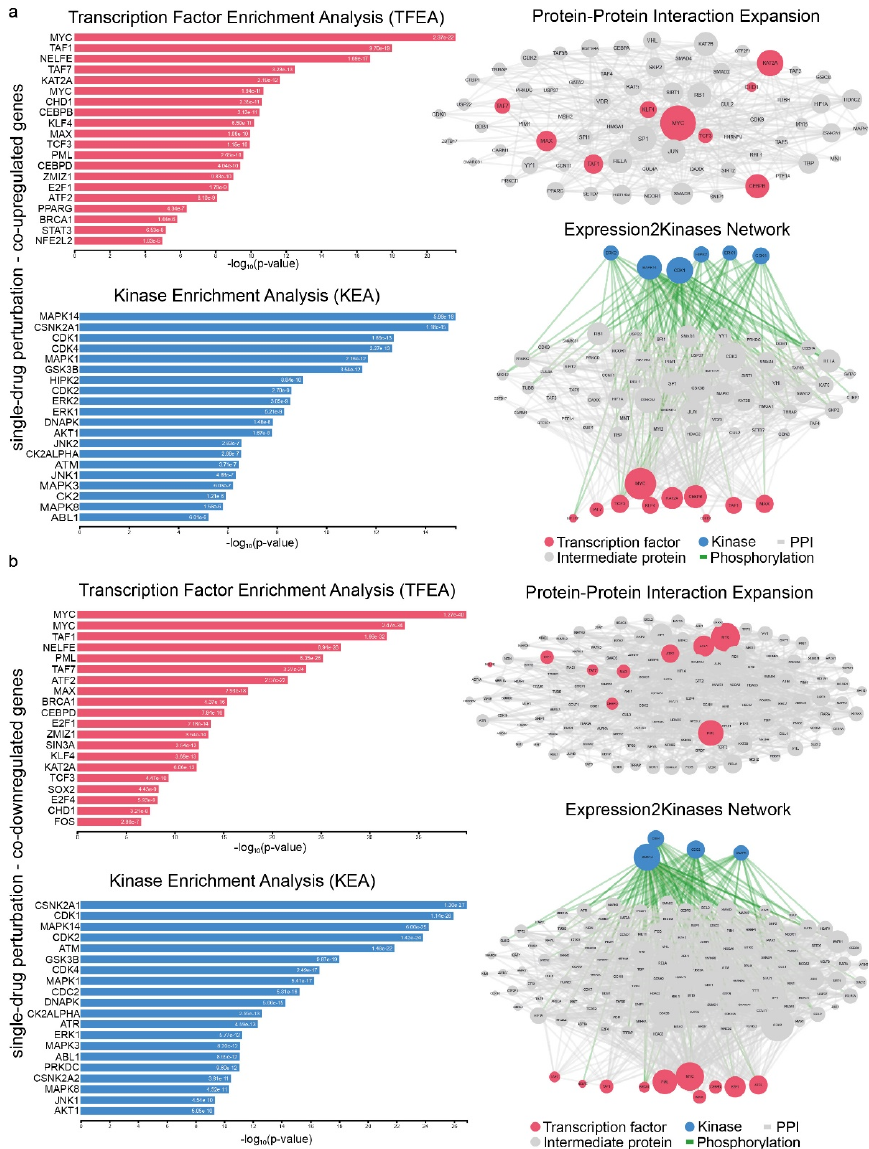
Figure 8. Upstream regulatory networks for co-upregulated ( a ) and co-downregulated ( b ) gene signatures in single-drug perturbation experiments in lung cancer. The networks depict transcription factors (TFs, red nodes), intermediate proteins (gray nodes), and kinases (blue nodes). Gray edges indicate PPI interactions and green edges depict kinase-driven phosphorylation events. Node size is relative to